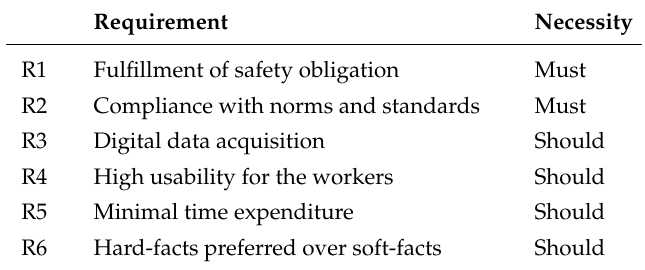
Table 2. Requirements regarding the inspection process and data